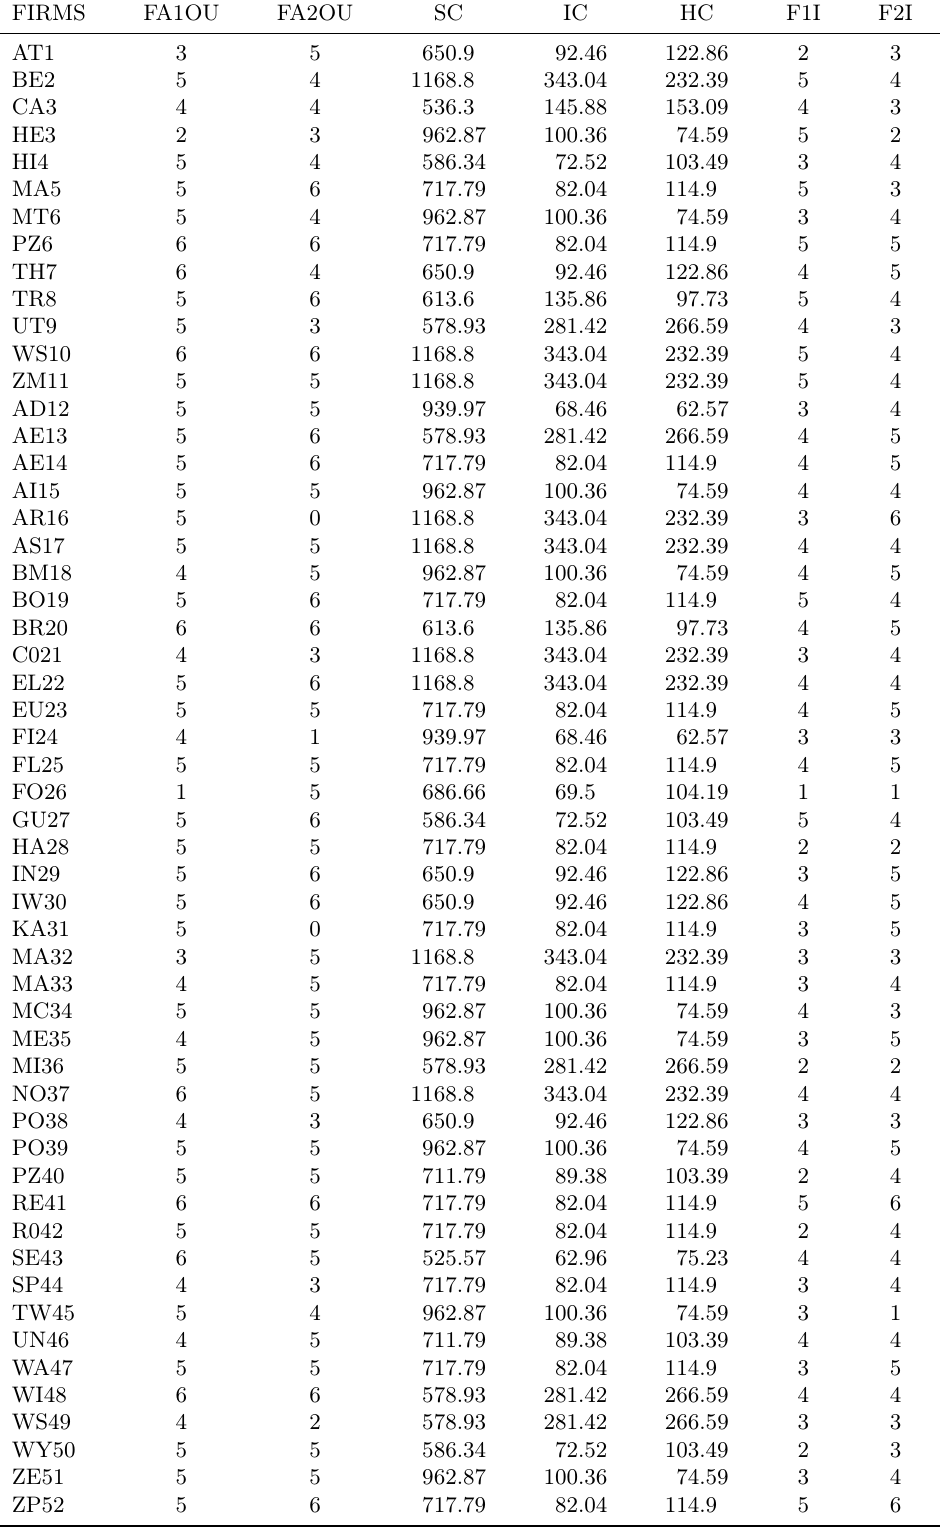
Table 3: Database on drivers and perceptions of individual firms based in the Aviation Valley and located in different powiats in the Podkarpackie voivodship FIRMS FA1OU